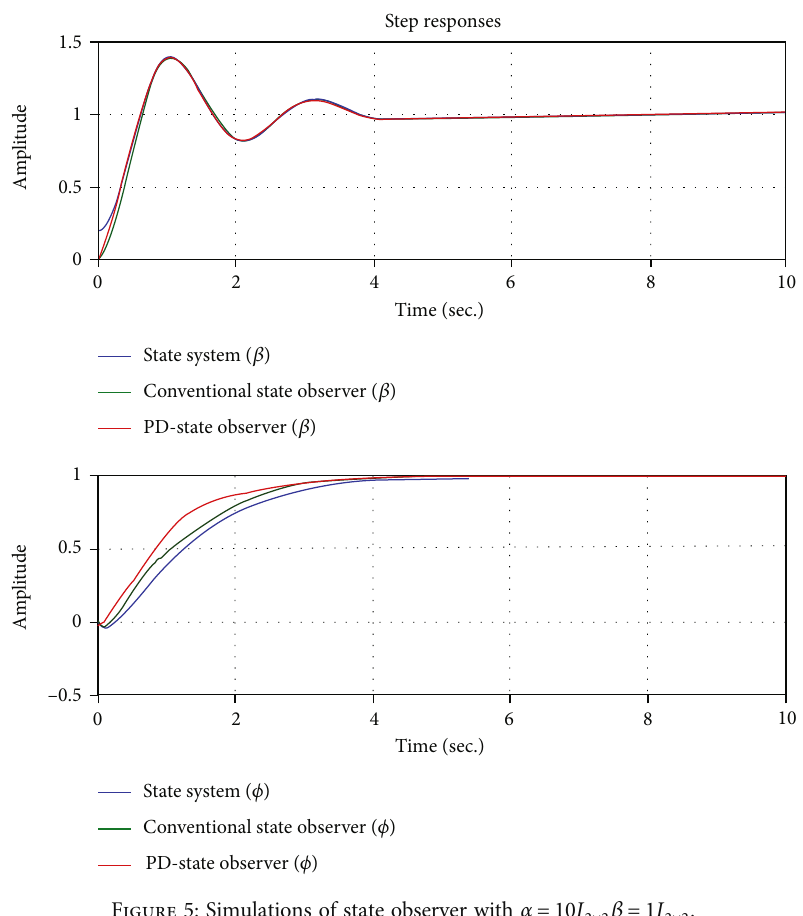
Figure 5: Simulations of state observer with α = 10 I